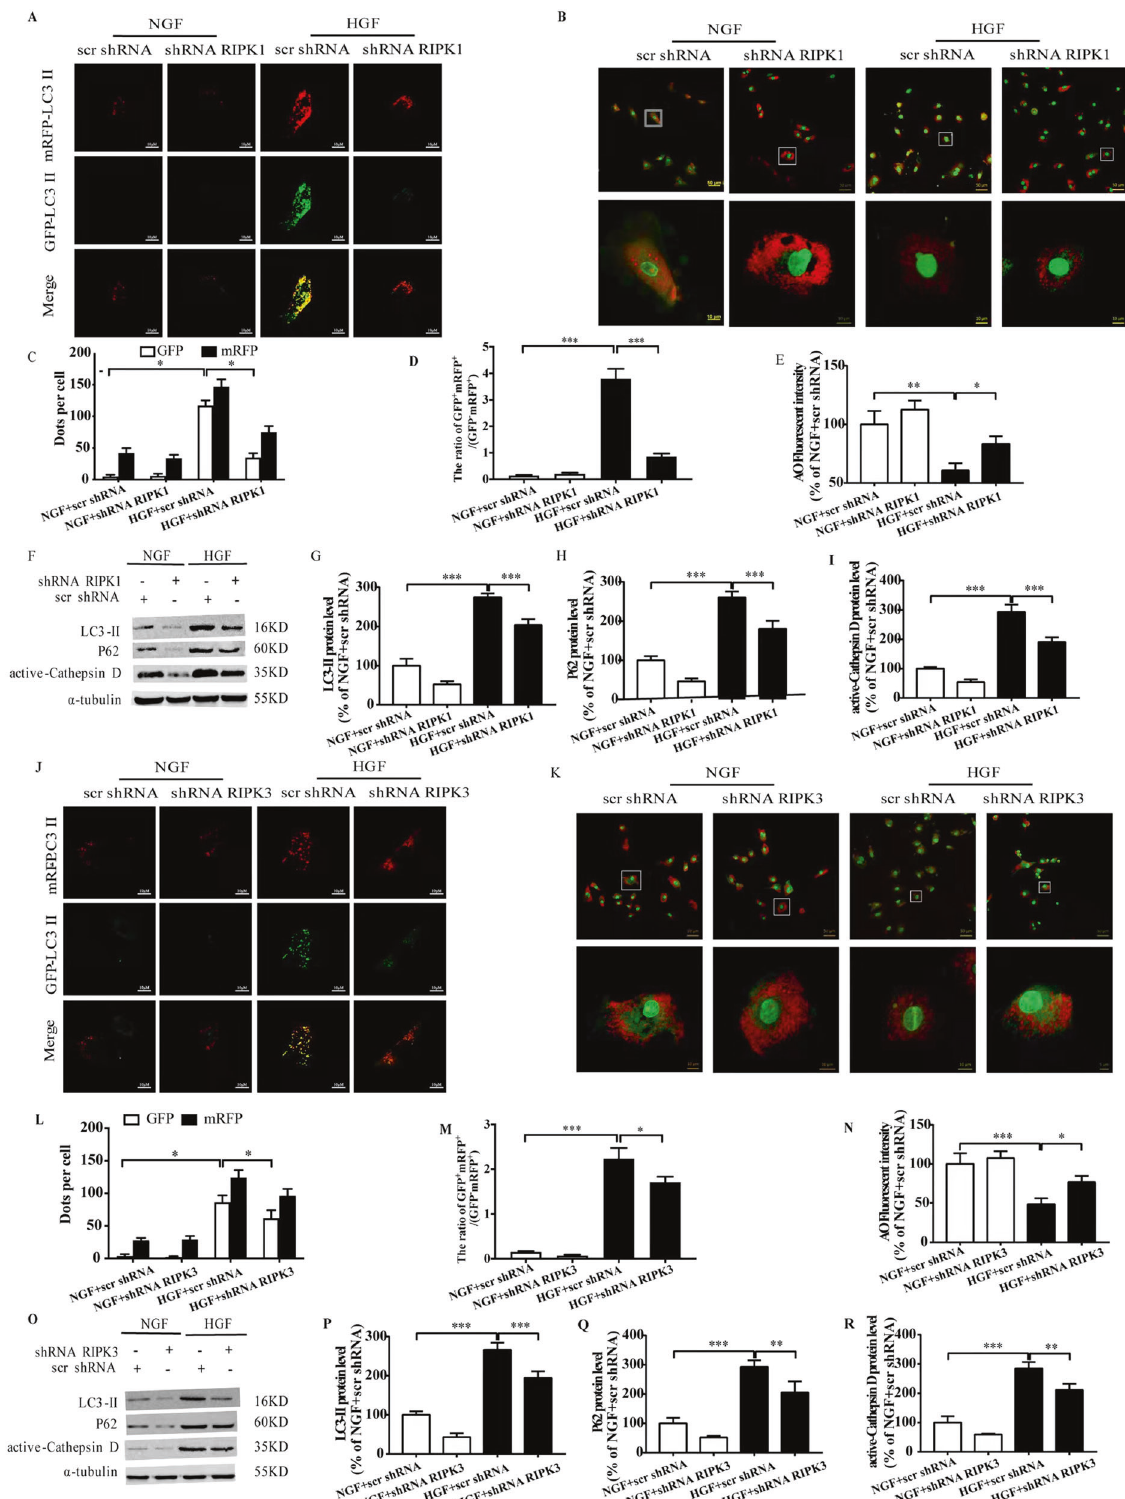
Fig. 2 RIPK1/RIPK3 silencing restored autophagic fl ux in HGF-treated CFs. Confocal images and the ratio of GFP + mRFP + /(GFP - mRFP + ) and AO fl uorescence intensity ( A – E , J – N ); Representative images and percentages of LC3-II, P62, active-cathepsin D ( F – I , O – R ). n = 3 per group. Means ± SD. * P < 0.05, ** P < 0.01, *** P < 0.001. NGF normal glucose and fat group, HGF high glucose, and high fat group, AO acridine